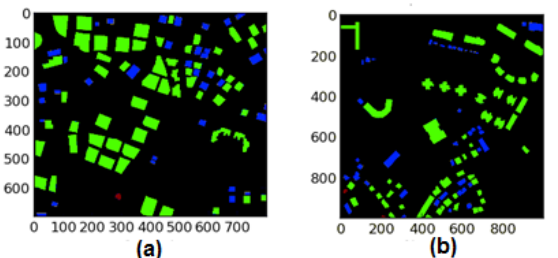
Figure 9. Detected building rooftop result on the post-event dataset (Green: True positive; Red: False positive; Blue: False negative).